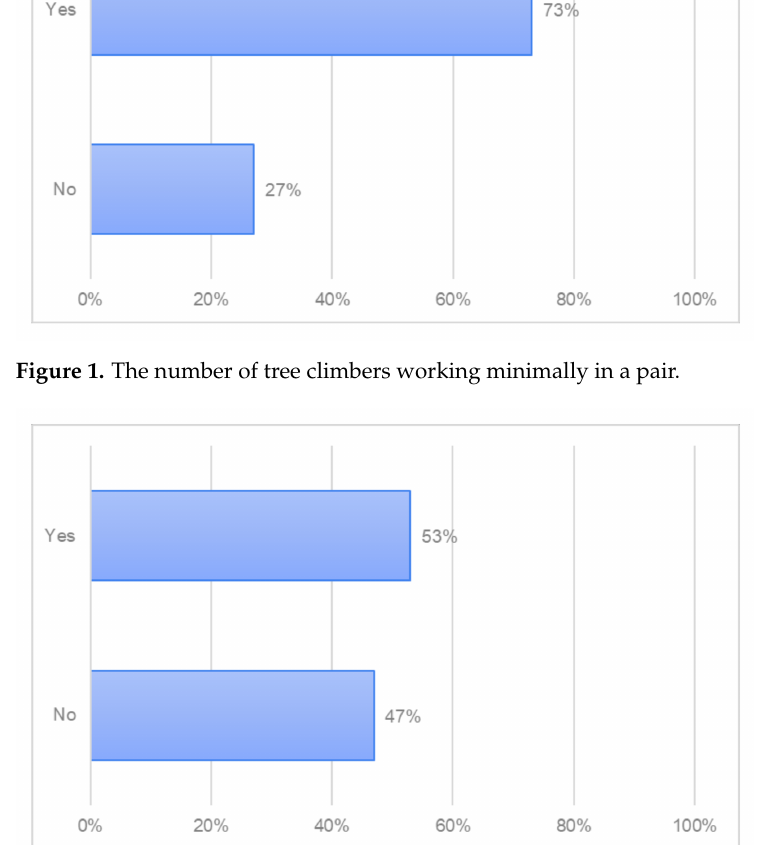
Figure 2. Qualifications of ground workers.